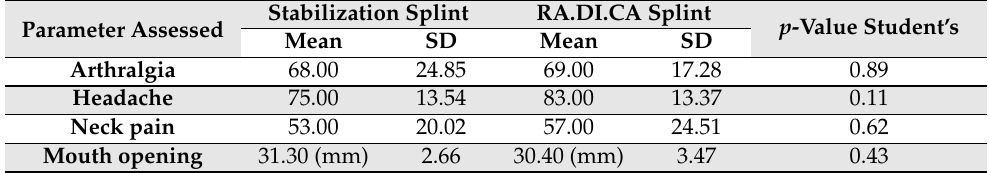
Table 1. Baseline general and clinical characteristics for each study group. Pain scores are reported according to verbal numeric scale values and mouth opening is expressed in mm. Student’s t -test with p <